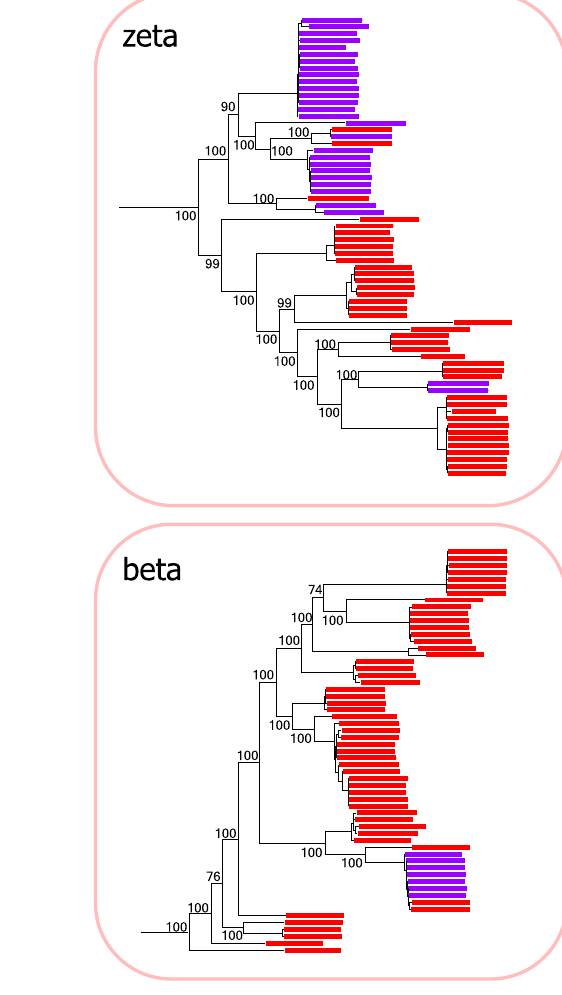
Fig. 6 DNA polymerase switches in the evolution of crAss-like phages. The left panel shows a schematic phylogenetic tree of TerL for the entire crAss- like phage assemblage, with the branches collapsed into triangles. The right panels show the expanded beta and zeta branches. The portions of the triangles (left panel) and the tree leaves (right panels) are colored by the DNAP type, red for PolA and purple for